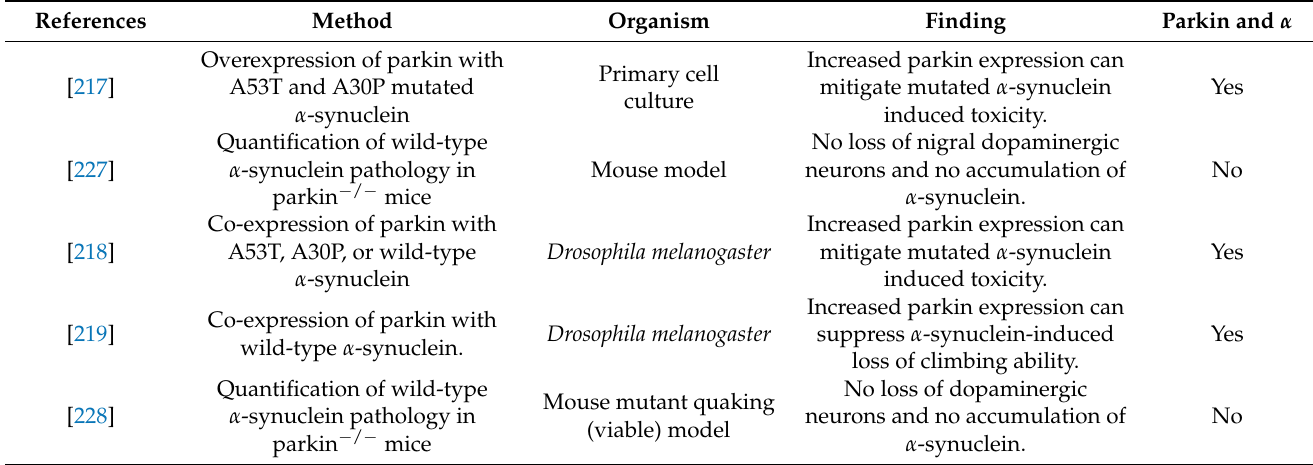
Table 3. Summary of experiments investigating parkin function on α -synuclein-induced toxicity in vivo and in